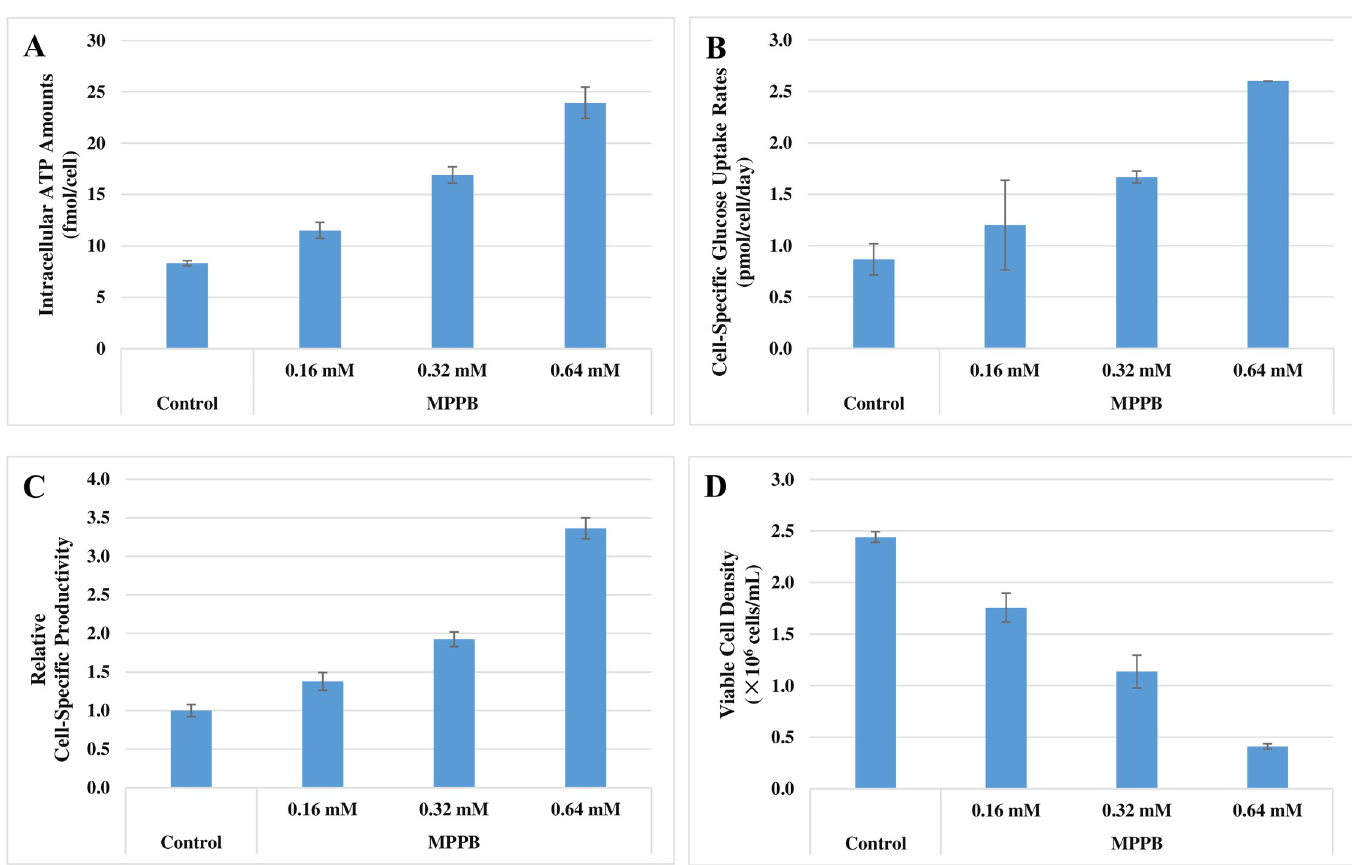
Fig 6. MPPB increased both intracellular ATP amounts and cell-specific glucose uptake rates and suppressed cell growth. Given previous results, the tested MPPB concentrations ranged from 0.32 to 0.64 mM. Intracellular ATP amounts ( A ), cell-specific glucose uptake rates ( B ), relative cell-specific productivity ( C ), and viable cell density ( D ) were evaluated on day